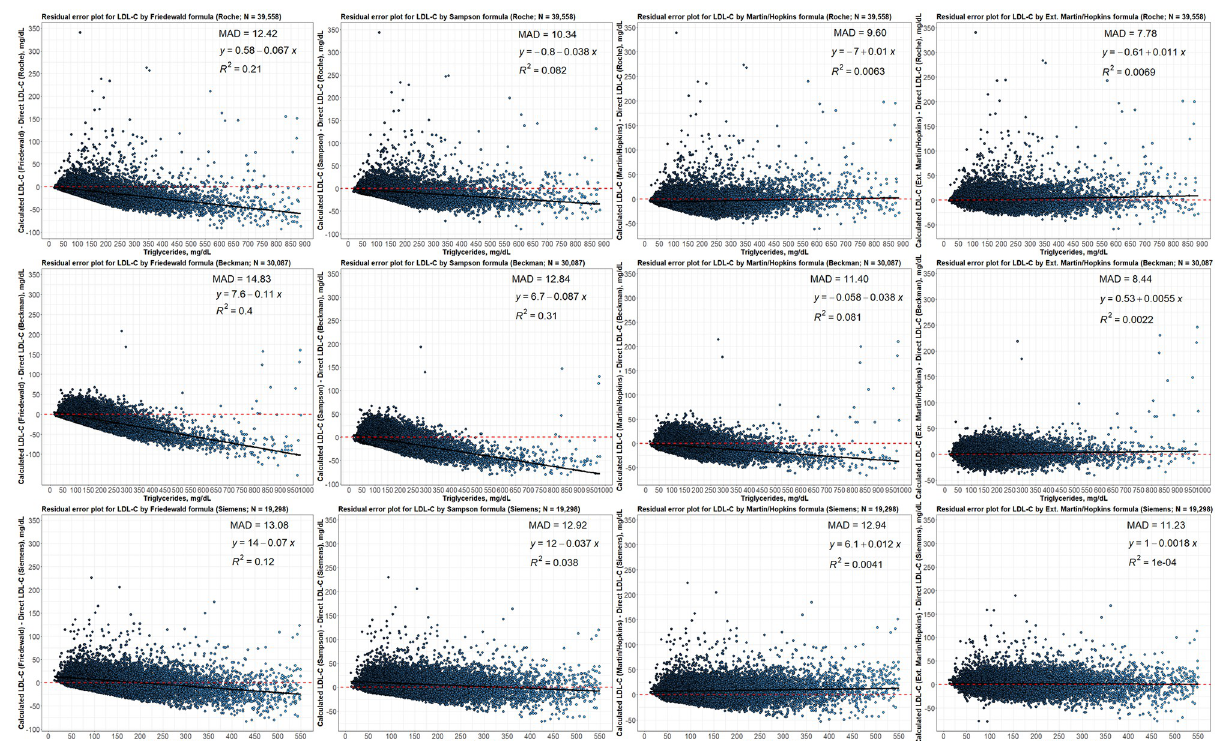
Fig 7. Residual error plots for LDL-C by different formulas concerning to different direct assay methods. While the values on x-axis show TG levels, the values on y-axis shows the difference between estimated LDL-C (by Friedewald, Sampson, Martin-Hopkins or extended Martin-Hopkins) and direct LDL-C levels (calculated by Roche, Beckman or Siemens). The mean absolute deviation (MAD) for each possible case is also given in each panel for each dataset.